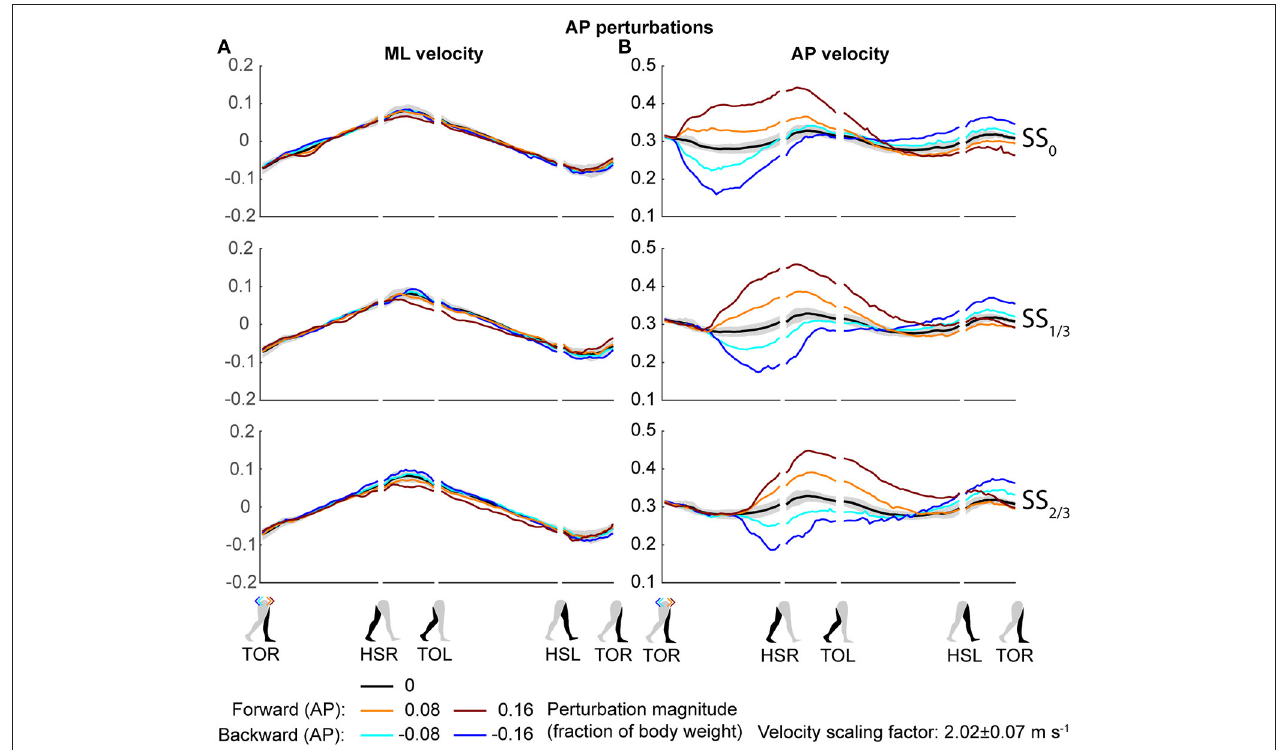
FIGURE 3 | COM velocity profiles following AP perturbation. (A) ML COM velocity in response to AP perturbations. (B) AP COM velocity in response to AP perturbations. Top, middle, and bottom rows correspond with perturbation onset instances of SS 0 , SS 1 / 3 , and SS 2 / 3 , respectively. Data is shown as a function of the gait phase. Colors indicate the various perturbation magnitudes. Shaded areas indicates the subject-standard deviation for the unperturbed condition. It is not shown for perturbed conditions to prevent image cluttering. Data is shown